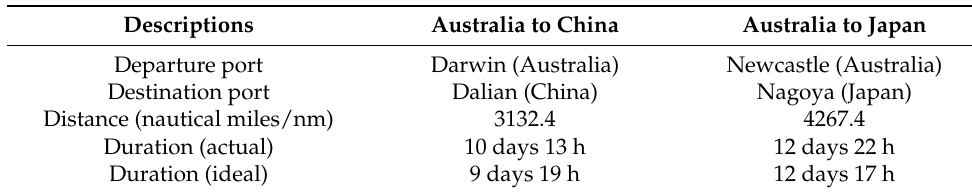
Table 2. Routes from Australia to China and Japan.